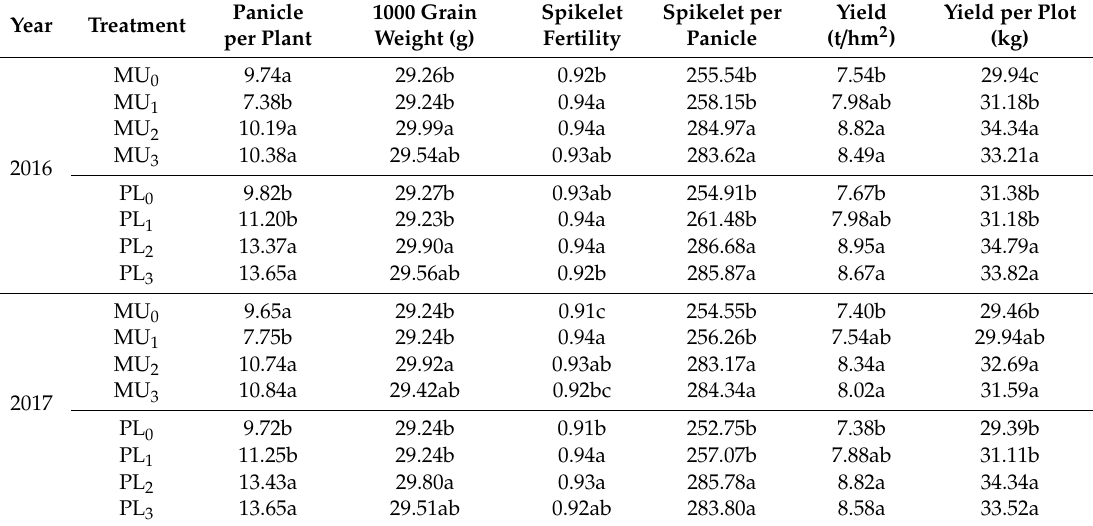
Table 4. Comparison of the rice yield and its component for di ff erent straw incorporation treatments during 2016 and